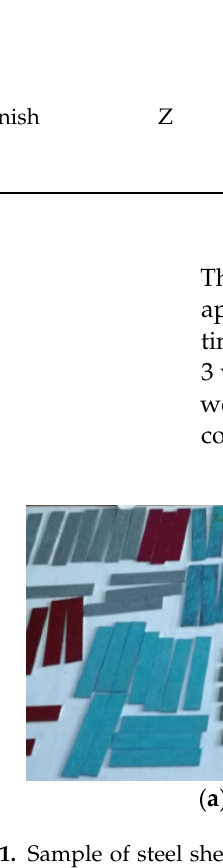
Table 6. Description of polymer varnishes used to produce varnish coats on steel samples.